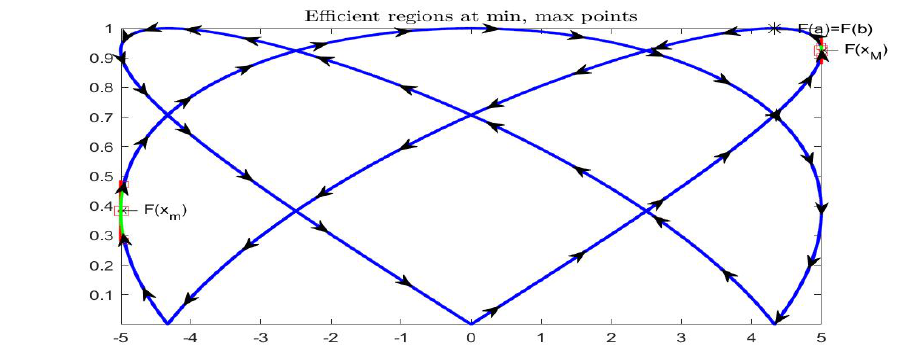
Figure 20. Periodic Example 1: midpoint representation of function F ( x ) ; marked points are F ( x m ) and F ( x M ) and the efficient E min ( F ; x m ) and E max ( F , x M ) points are marked in green color.